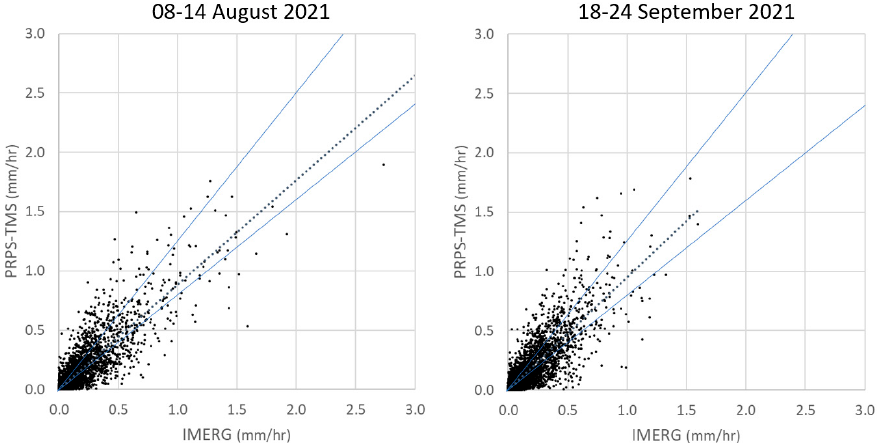
Figure 5. The scatter plots showing the IMERG vs. PRPS–TMS mean precipitation intensity for the two 1-week periods. The outer solid blue lines define the ± 25% limits, while the inner thin dashed lines show the best-fit line through the data.